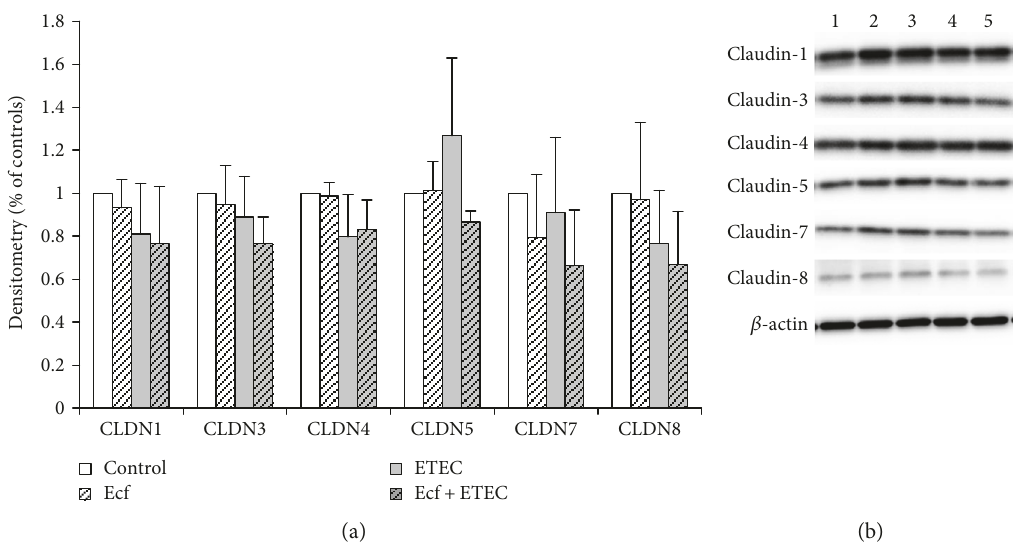
Figure 3: Protein expression (Western blot) of claudin-1, claudin-3, claudin-4, claudin-5, claudin-7, and claudin-8 after treatment with bacterial strains (Ecf, ETEC, and Ecf +ETEC). (a) Protein expression relative to respective controls [means ± SEM]. Samples were taken after 8h. No di ff erences were observed between treatment groups. N = 3 independent experiments per bar. (b) Exemplarily, data of one Western blot is shown. 1=control (8 h), 2 =Ecf (8 h), 3 =ETEC (8 h), 4 =Ecf (8 h)+ETEC (6h), and 5=Ecf (10 h)+ ETEC (8 h). Sample 4 was included as a control to rule out e ff ects of longer total bacterial incubation (preincubation) and was not included in the statistical analysis shown in (a).